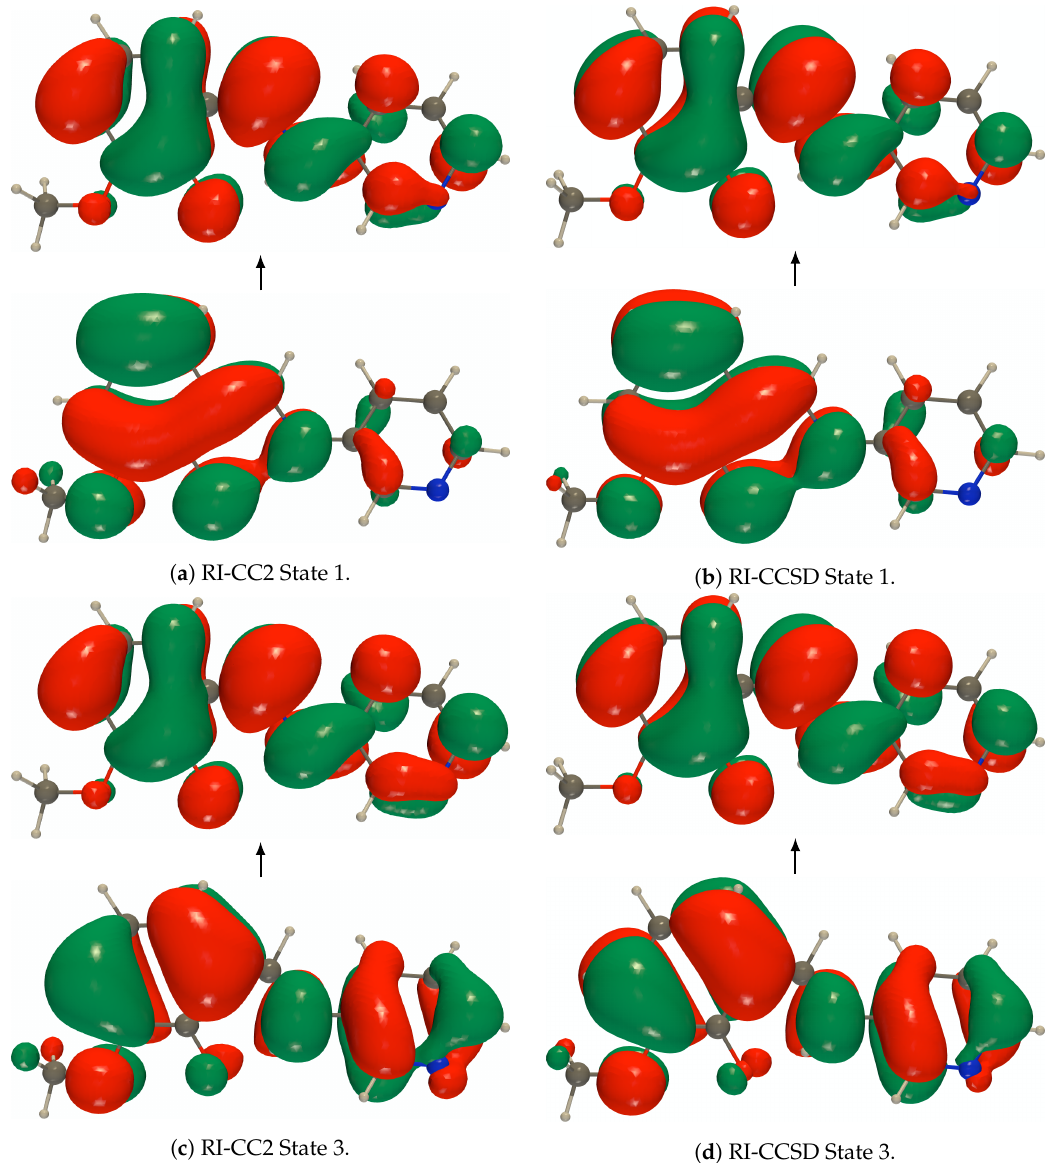
Figure A2. def2-TZVPD NTOs (holes below the arrows and particles above them, the red (green) lobes are the positive (negative) ones) of the isolated PYV3 [PYV3] keto form (isovalue of